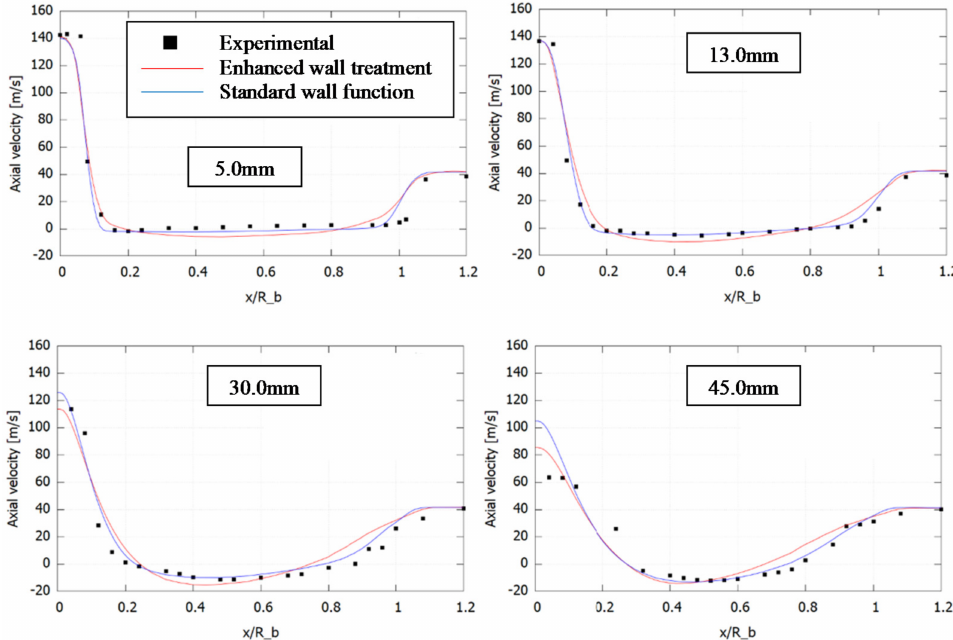
Figure 10. Axial velocity profiles at increasing axial distances. FGM/CRECK. Complete experimental data available at reference [15].